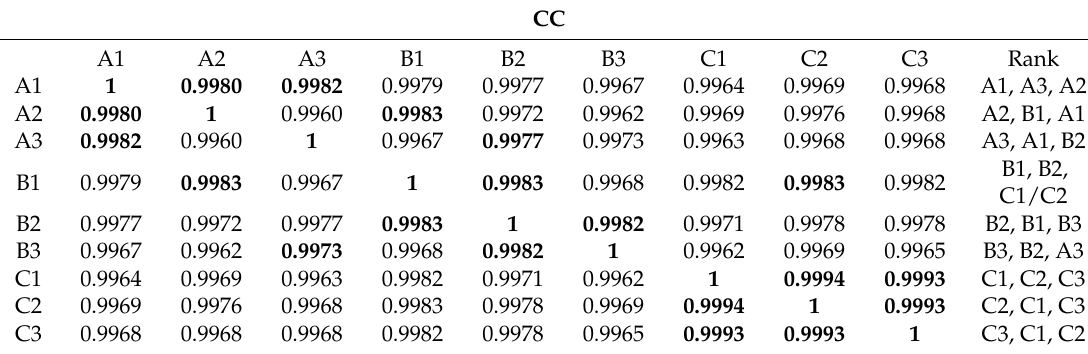
Table 1. The performance of CC for the AVIRIS dataset.